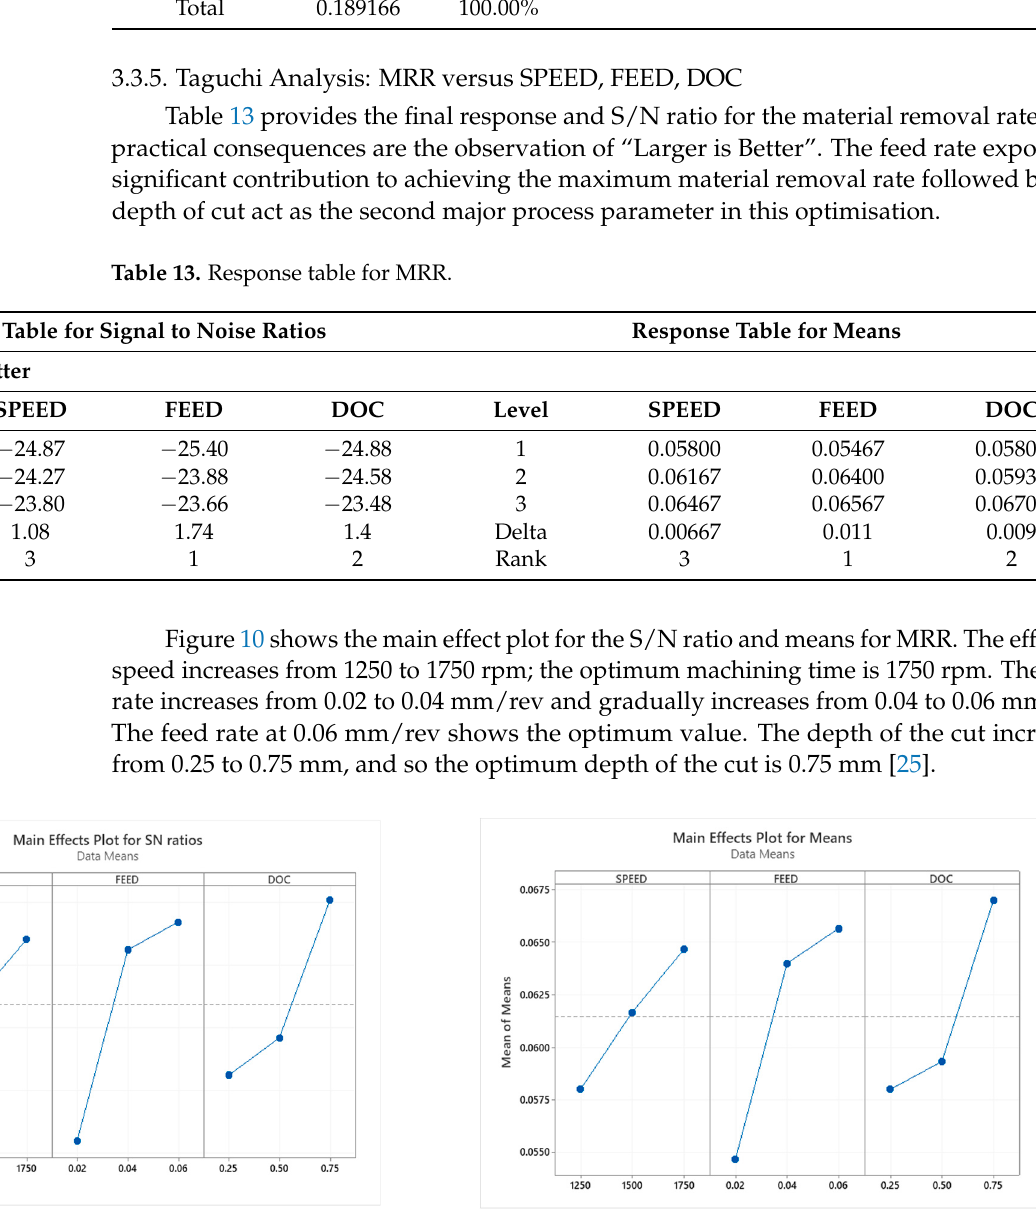
Figure 10. Main effect plot for SN ratio and means for MRR.